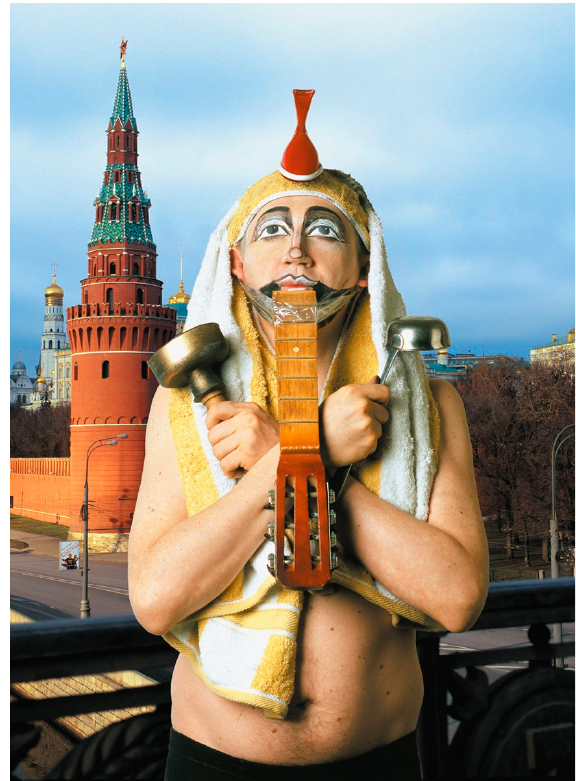
Figure 8. Vlad Mamyshev-Monroe. From the series “Star3” (2005), https://vmmf.org/series/view?id=3#work-series-3-3 (accessed on 8 September 2022).